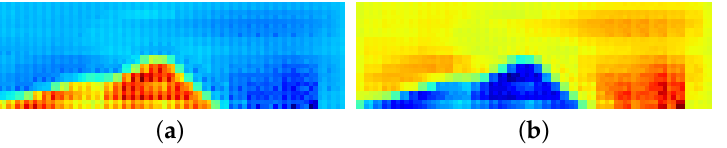
Figure 13. Model—ResNet-18, layer 94, total channels—256, type—transpose convolutional layer. ( a ) Output of channel 16. ( b ) Output of channel 17.